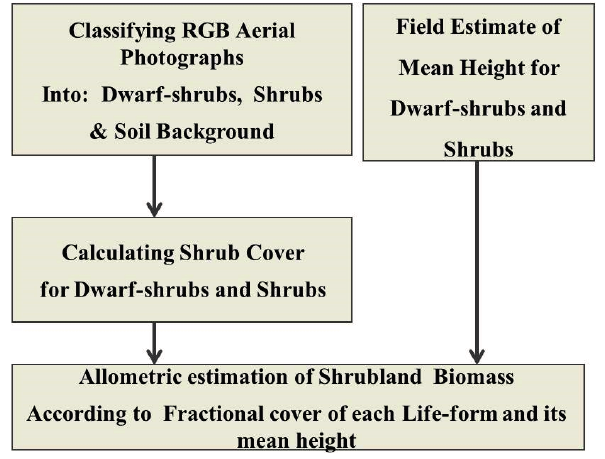
Figure 7. An integrated allometric approach for calculating biomass by combining field estimates of shrub heights with air photography-based estimates of cover fractions for shrub and dwarf shrub life